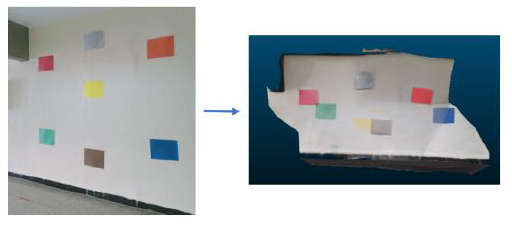
Figure 6. Effect of the colored sheets.